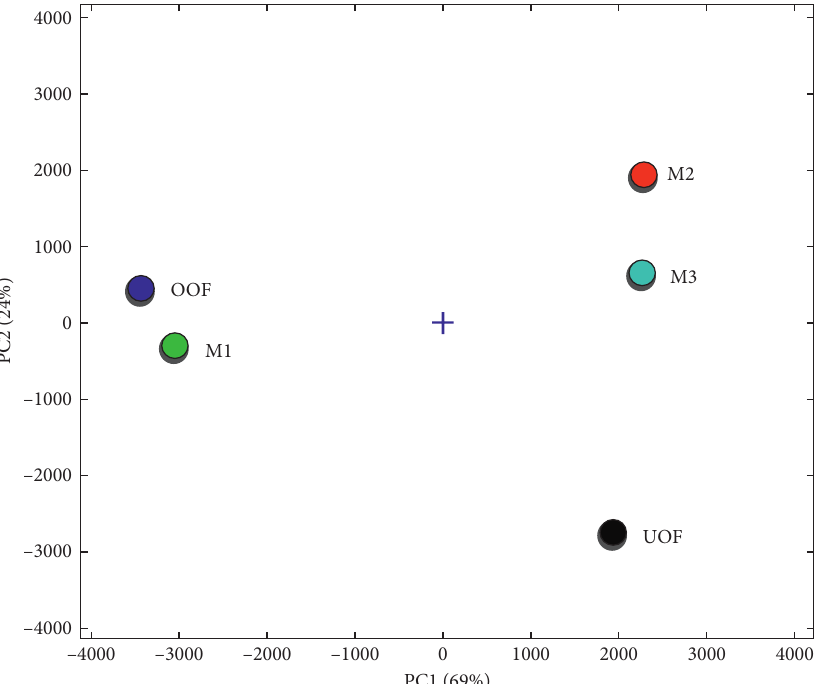
Figure 8: PCA plot of volatile compounds of steamed bread made from wheat flour added with different ratios of overozonized wheat